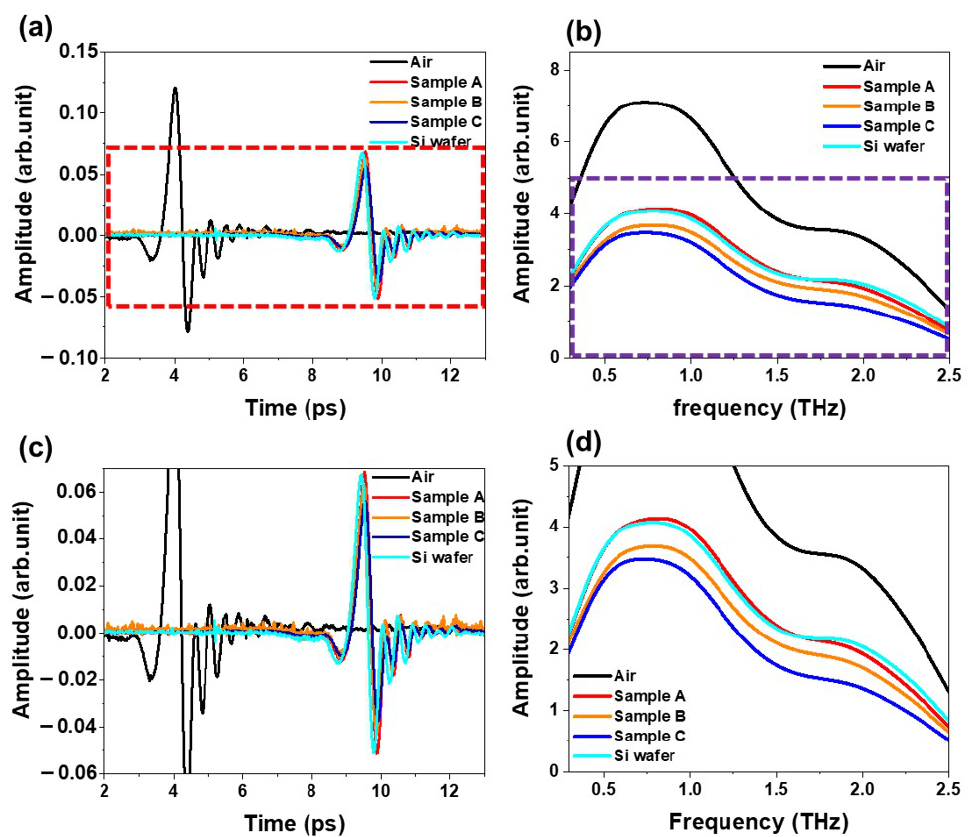
Figure 4. ( a ) Time-domain waveform of the transmitted THz pulse, ( b ) and its corresponding Fourier- transform frequency spectra of air, Si wafer, and samples (A, B, and C). ( c , d ) These are enlarged graphs of the square dotted lines shown in ( a , b ),